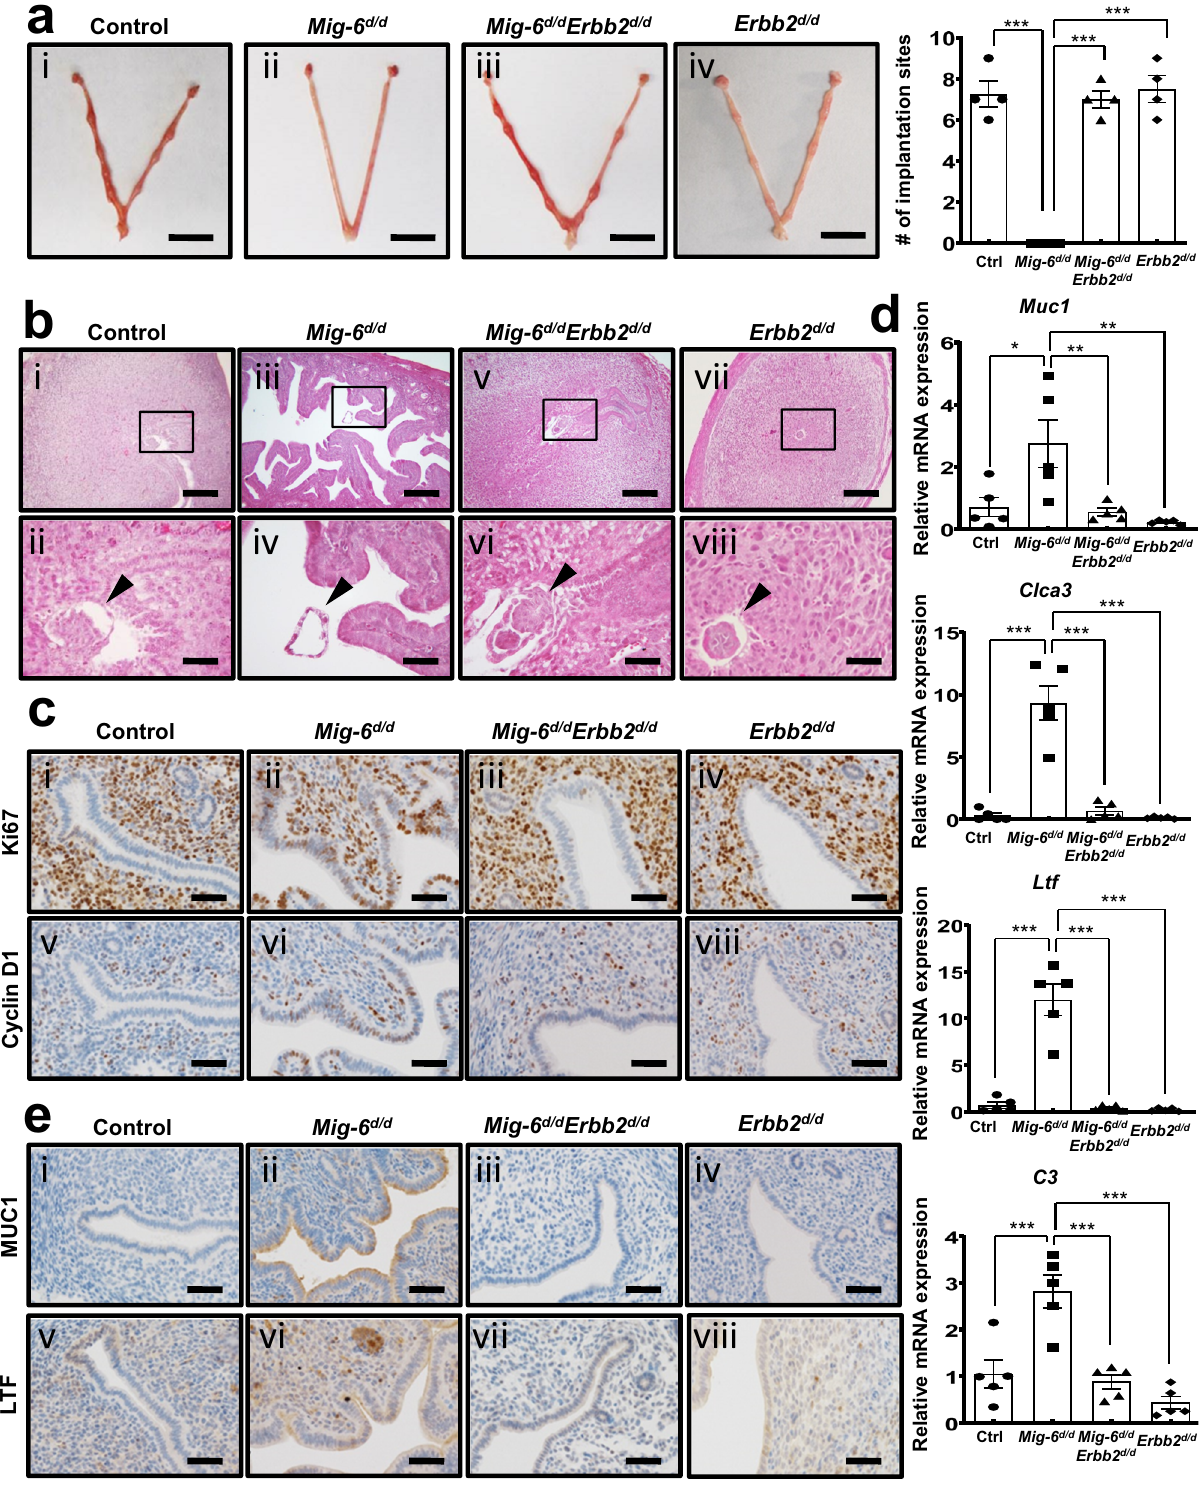
eutopic endometrium from the mice with endometriosis com- pared to the sham group. This result demonstrated that reduced MIG-6 expression is associated with endometriosis development. We developed a mouse model of endometriosis based on Pgr cre/ + and mT/mG reporters that produces endometriotic lesions highly similar to those in humans. A mouse model in which excised human endometrial fragments are introduced into